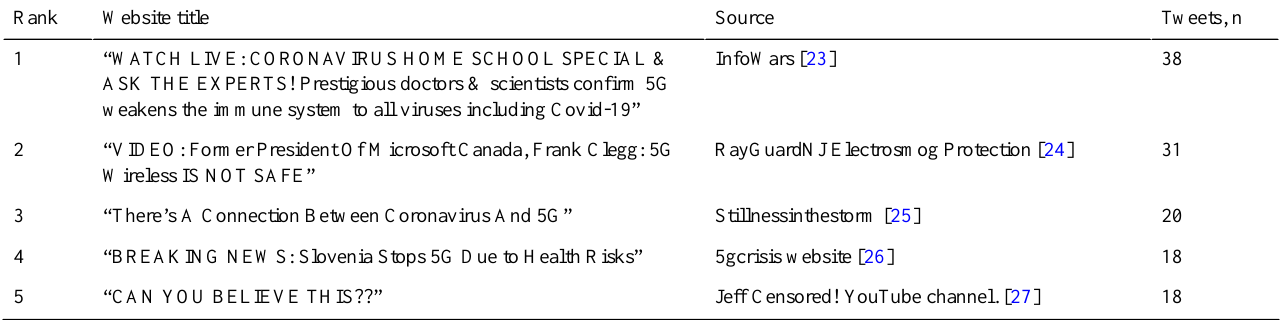
Table 2. Influential web sources.